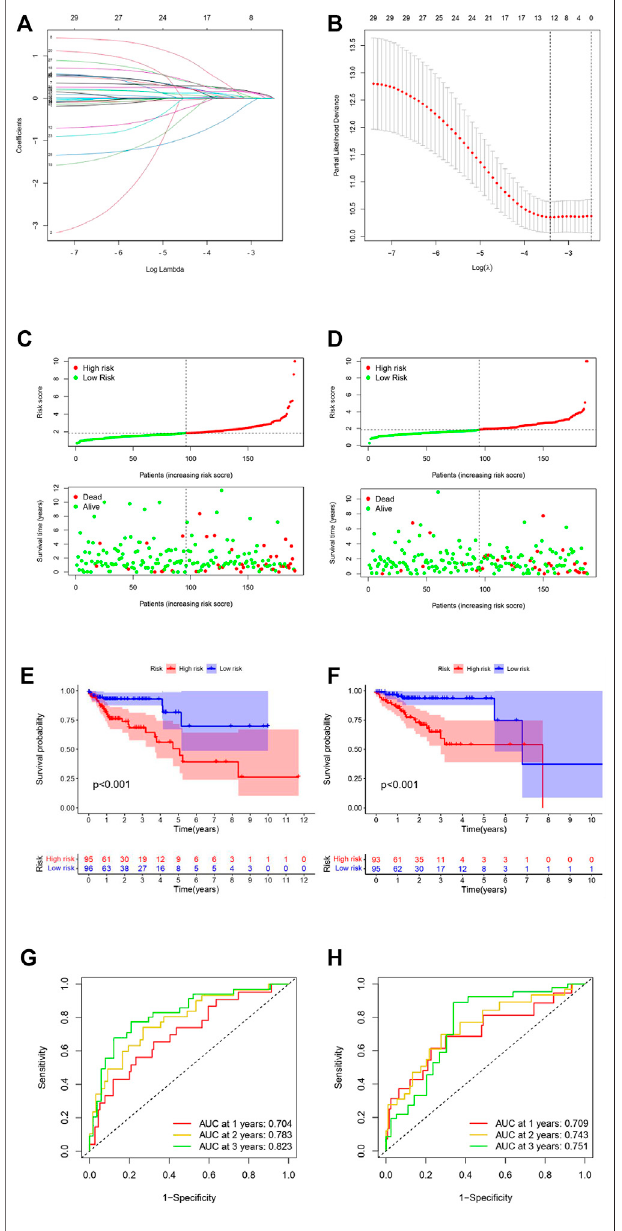
FIGURE 3 | Construction and validation of the risk model. (A,B) LASSO Cox analysis identi fi ed the best parameters and optimal coef fi cients. (C,E,G) Analysis results of the training set. (D,F,H) Analysis results of the testing set. (C,D) Risk score distribution of m6A-LPS (panel above) and patient survival status (panel below). The green dots represent surviving patients, and the red dots represent non-surviving patients (E,F) Survival analysis revealed that the low-risk group patients had a better prognosis. (G,H) ROC curves of m6A-LPS for predicting 1-, 2-, and 3-year